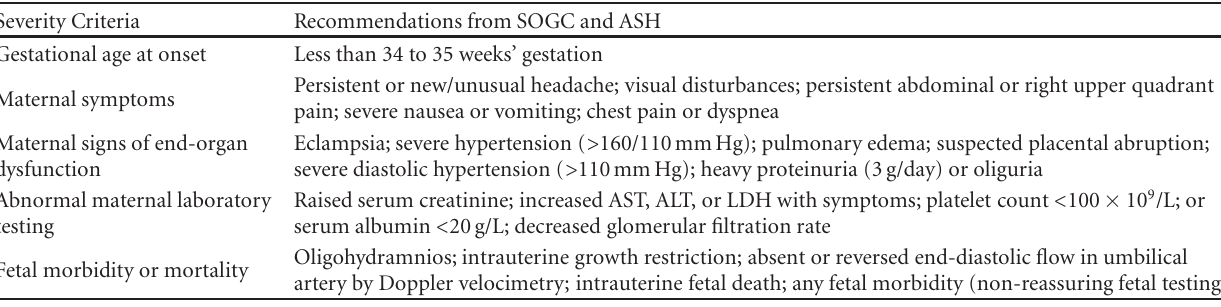
Table 1: Criteria for classification of severe preeclampsia [8,